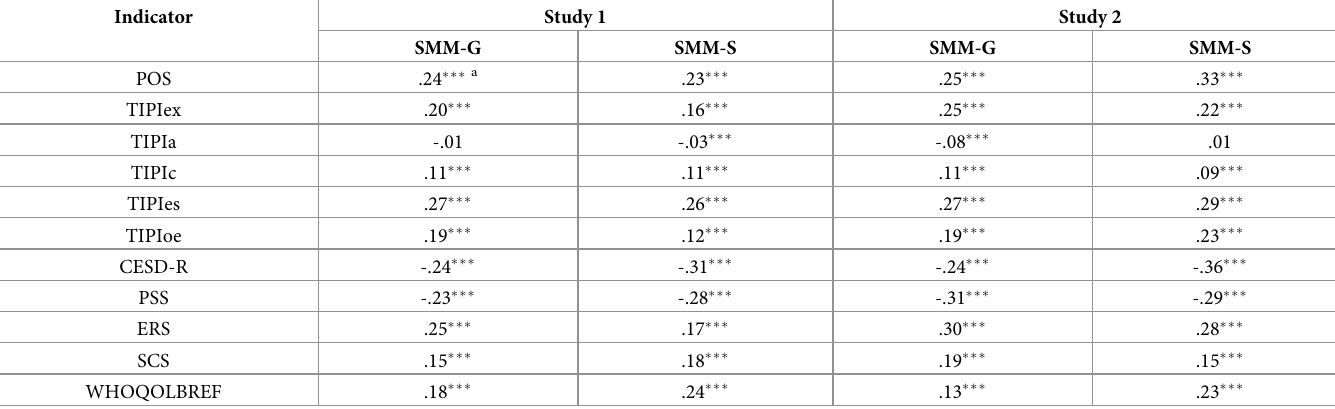
Table 7. Pearson correlation coefficients between SMM and other scales (Study 1 and Study 2).